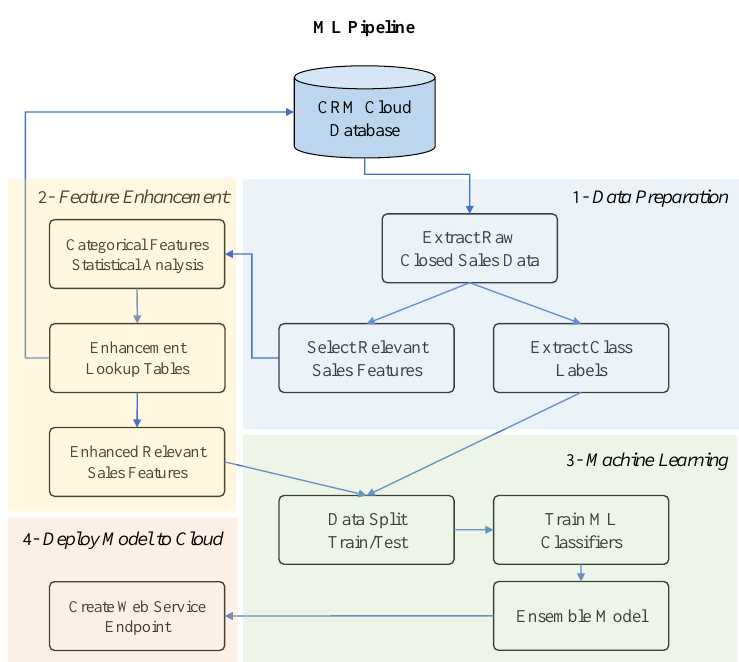
Figure 5. ML Pipeline: In four major steps the pipeline extracts and enhances sales data from a cloud database, trains an ensemble of ML classification models on the data, and eventually creates a cloud endpoint for the